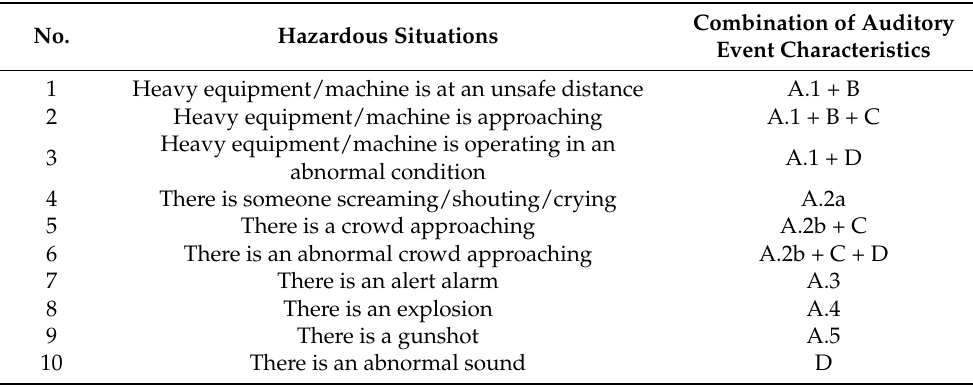
Table 9. List of hazardous situations and required auditory event characteristics (see Table 8 for the auditory event